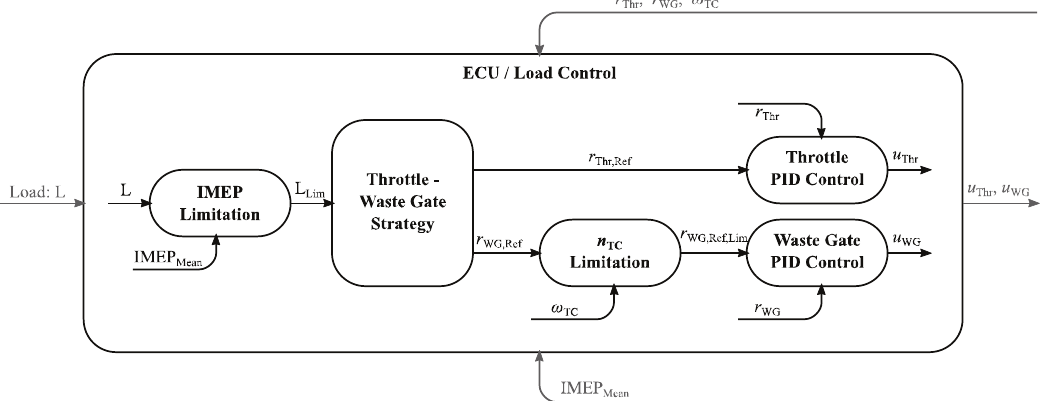
Fig. 4. Complete load control structure, implemented on the